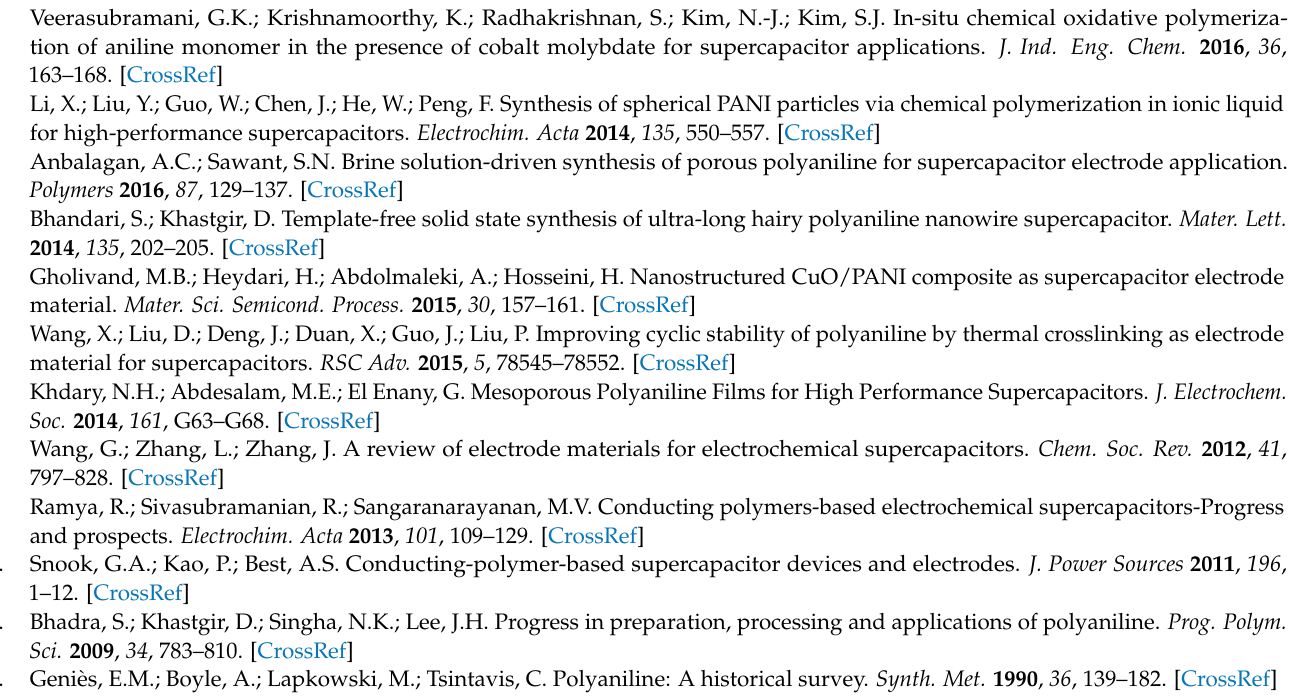
Table S1: Main ATR-FTIR bands of synthesized PANI, Figure S4: Raman spectra of Pani/PIL and Pani/HSO 4 using ( a ) 633 and ( b ) 514 nm excitations, Figure S5: Graphene (Gr) vs. graphene oxide (GO), Figure S6: AT-IR spectra of the PANI/HCl, PANI/PIL and PANI/PIL/GO nanocom- posites (B: benzoid units, Q: quinonid units, ν : stretching vibration and ∆ : bending vibration), Table S2: Specific capacitance, energy and power densities at 10 A · g − 1 of PANI/HCl, PANI/PIL and PANI/PIL/GO 84/16, Figure S7: ( a ) CV curves at 100 mV · s − 1 and ( b ) specific capacitance as function of scan rate of Gr and GO in H 2 SO 4 1 mol · L − 1 . CVs have been recorded using two electrodes configurations (symmetric capacitors). Specific capacitances are relative to the total weight of the electrodes in the symmetric